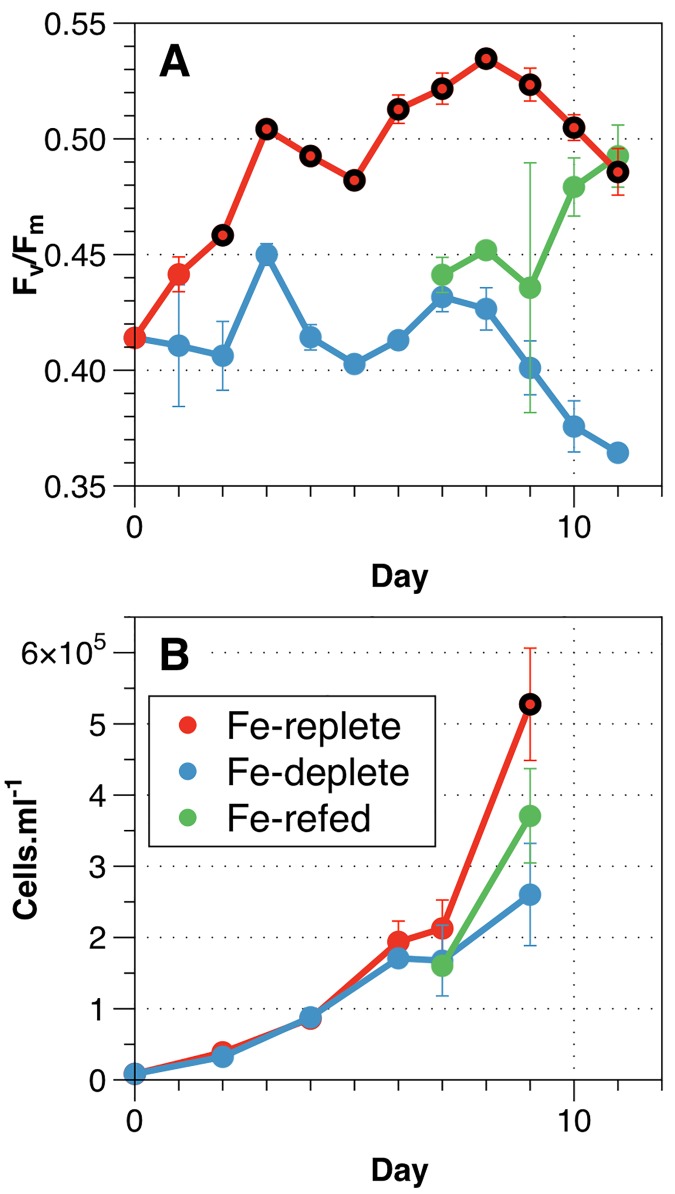
Culture physiology data.Physiological growth parameters observed throughout the culture experiment showing Fe-replete (red), Fe-deplete (blue) and Fe re-fed (green) samples. A) Photosynthetic efficiency (Fv/Fm). B) Cell counts (cells ml-1). Sampling for proteomic profiling was conducted on day 7, upon which assessment of re-fed cultures began. Time points where data show a statistically significant difference (Student's t-test, n = 3, P<0.05) between Fe-replete and Fe-deplete cultures are indicated by black outer circles for the Fe-replete data points.